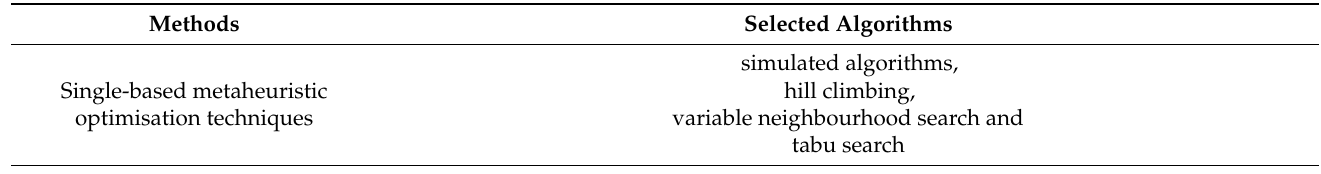
Table 3. Selected methods of metaheuristic optimisation with algorithms [116,136–138].